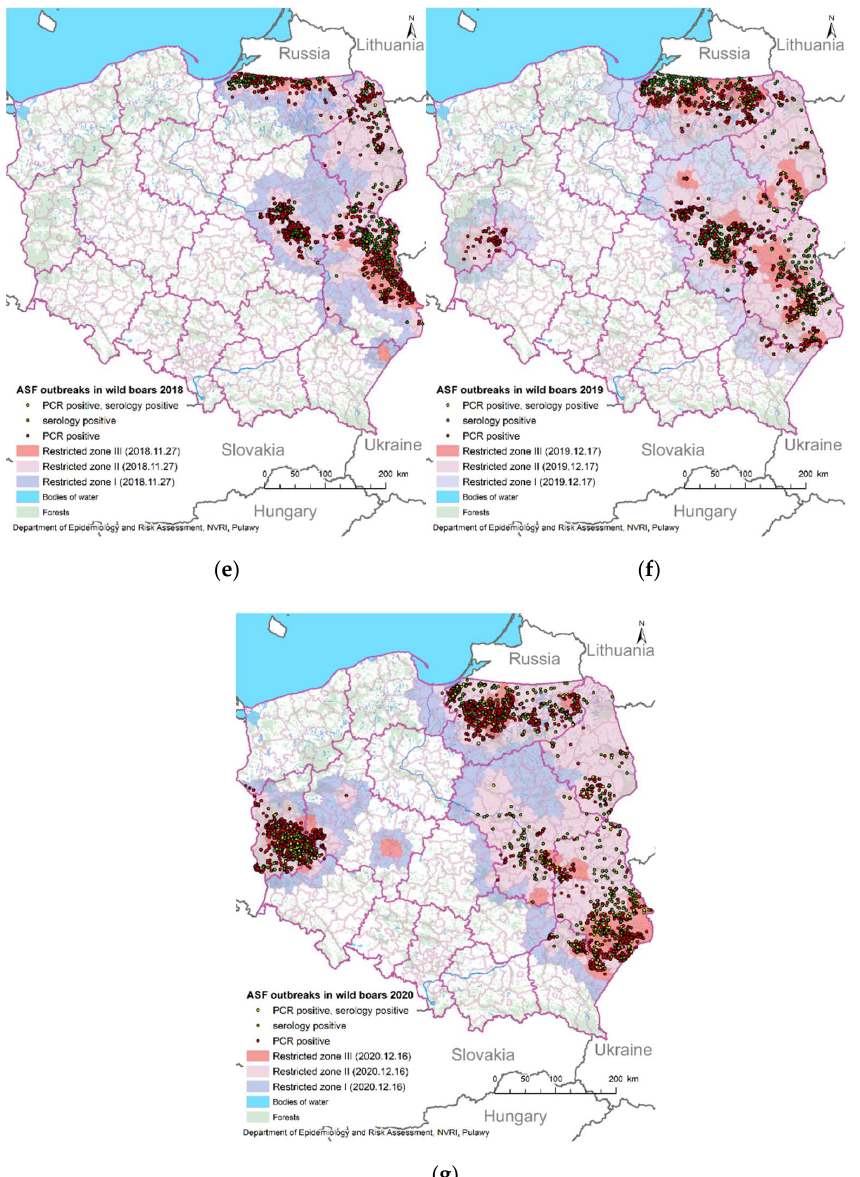
Figure 4. ASF-positive wild boars in Poland in: ( a ) 2014; ( b ) 2015; ( c ) 2016; ( d ) 2017; ( e ) 2018; ( f ) 2019; ( g ) 2020.